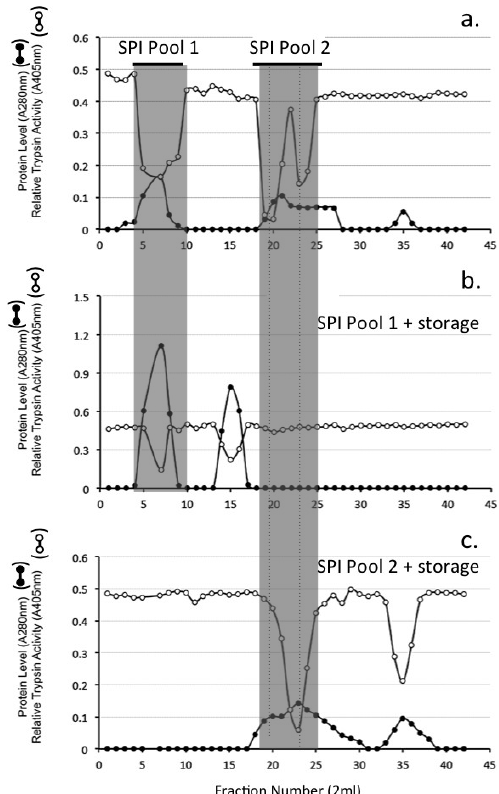
Figure 3. Sephadex G100 gel permeation chromatography of the ovine articular cartilage (AC) SPI sample from HA affinity chromatography ( a ) Fractions were monitored for protein (A280 nm) and relative trypsin inhibitory activity (A405 nm). Fractions containing trypsin inhibitory activity were pooled. Two SPI pools were collected as shown and separately re-chromatographed on the same column after 2 weeks storage at 4 °C ( b , c ).